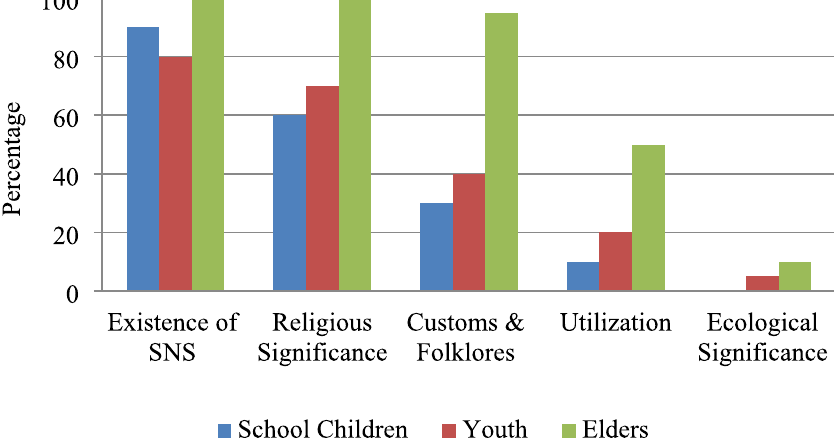
Fig. 3 Awareness of Various Dimensions of Sacred Groves, by Age